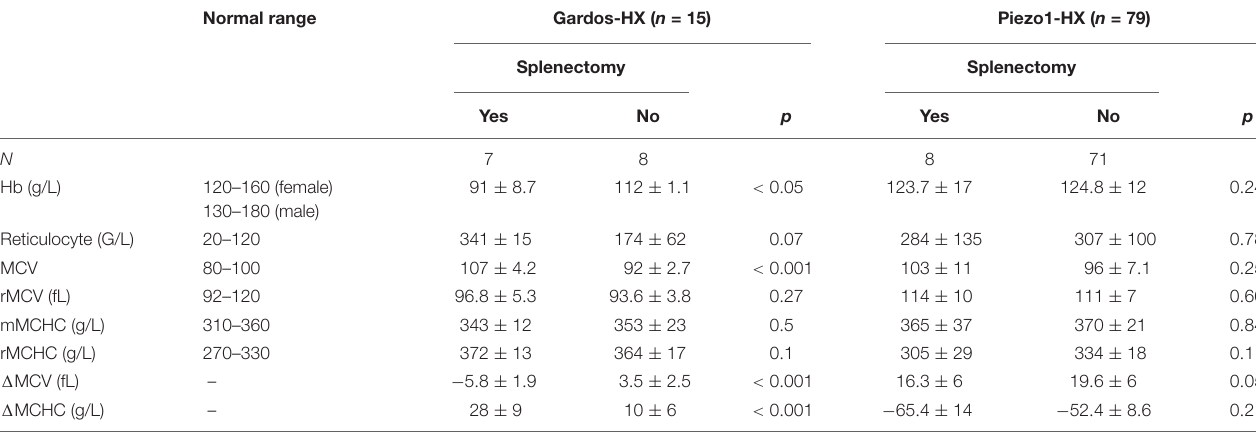
TABLE 1 | Comparison of red cell, reticulocyte and differential indices in splenectomized vs. non-splenectomized Gardos and Piezo1-HX cases (mean ± SEM, p : student T test). Normal range